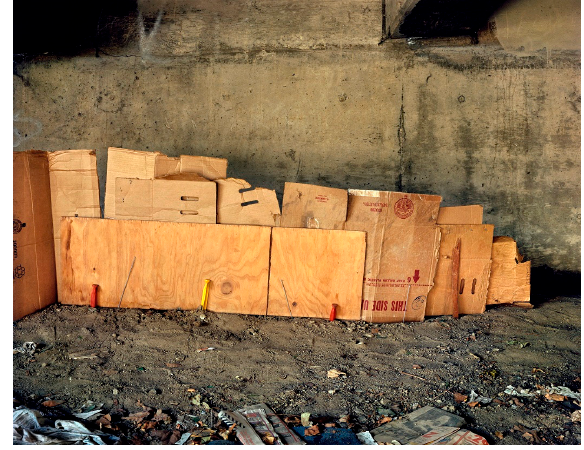
Figure 6. Anthony Hernandez, Landscapes for the Homeless #15 (1989), © Anthony Hernandez.